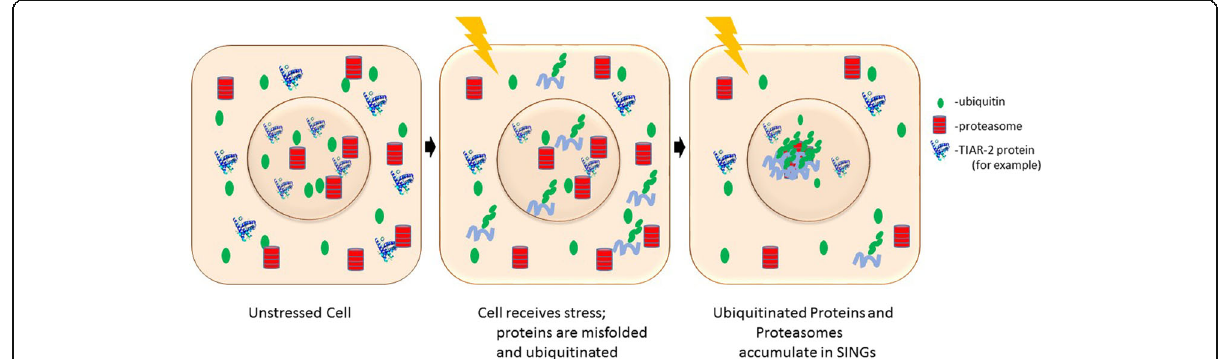
Fig. 11 Model for SING formation. Unstressed cells experience a healthy protein homeostasis. When cells are exposed to stressors that induce protein misfolding, the ubiquitin system adds K48-linked ubiquitin chains to the misfolded proteins. Ubiquitinated proteins and proteasomes localize to SINGs in the nucleus